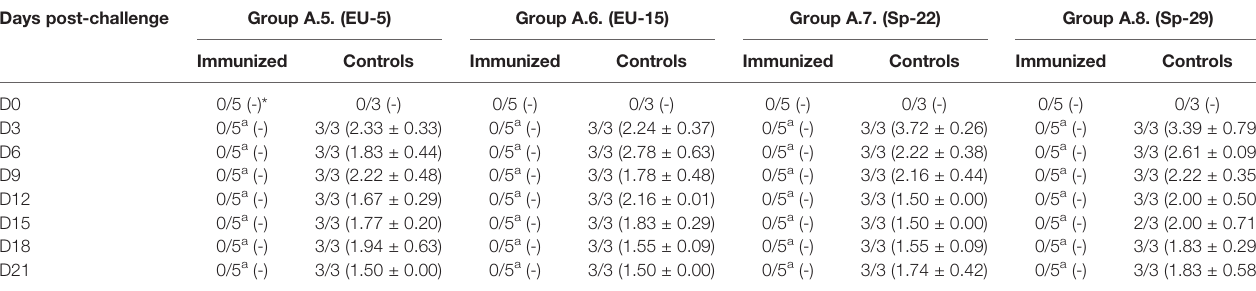
TABLE 3.2 | Virus isolation from serum samples collected in Experiment A (pigs immunized with Sp-3a). Days